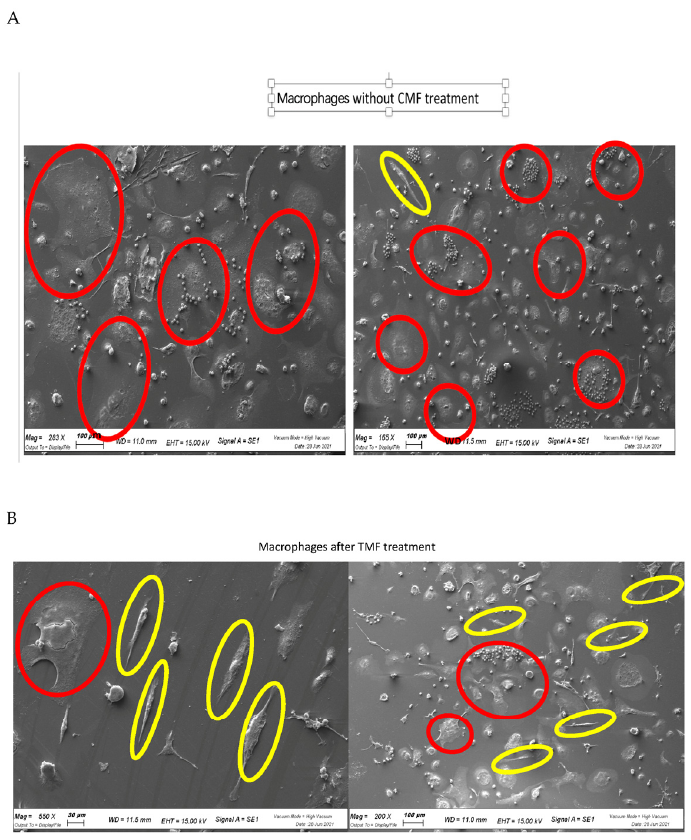
Figure 4. SEM analyses of the macrophages without the CMF treatment ( A ) acquires a M1 in- flammatory rounded shape phenotype (red circles). Treatment with the CMF ( B ) induced the M2 anti-inflammatory phenotype characterized by a long fusiform shape (yellow